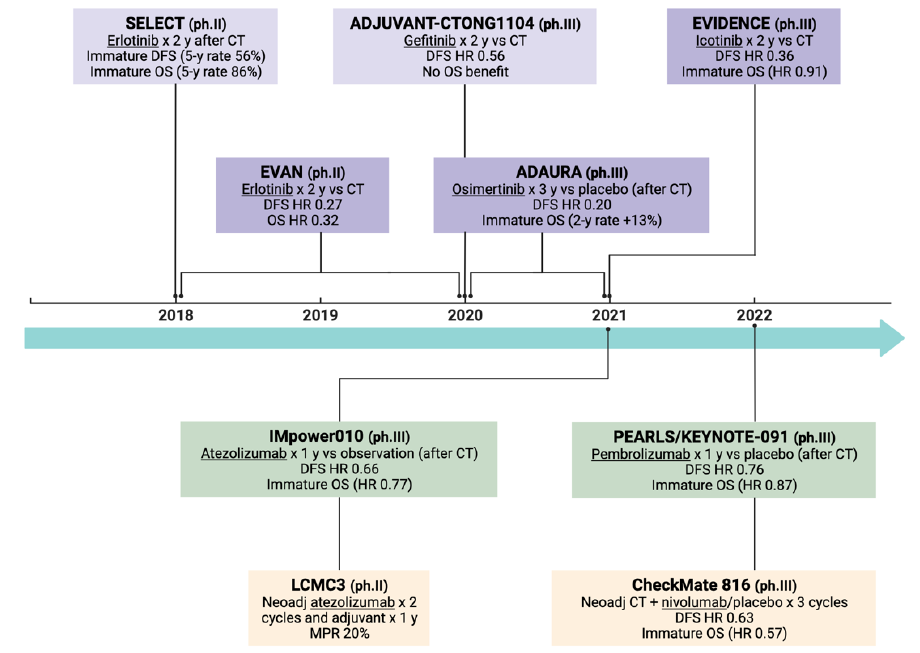
Figure 2. Main clinical trials in the adjuvant/neoadjuvant setting with EGFR-TKIs and ICIs with available literature data (created with BioRender.com (accessed on 15 June 2022)). Abbreviations: y, years; CT, chemotherapy; DFS, disease-free survival; OS, overall survival; neoadj, neoadjuvant; MPR, major pathological response; EGFR-TKIs, Epidermal Growth Factor Receptor tyrosine kinase inhibitors; ICIs, immune checkpoint inhibitors.